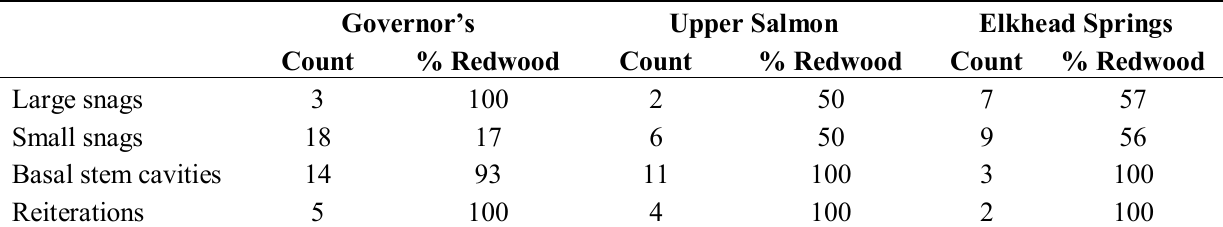
Table 3. Number of large snags (≥60 cm dbh, ≥10 m tall), small snags, and trees with basal stem cavities and reiterations in three 1-ha old-growth reference plots at Headwaters Forest Reserve, California. Percent redwood indicates how much of each tally was represented by redwood